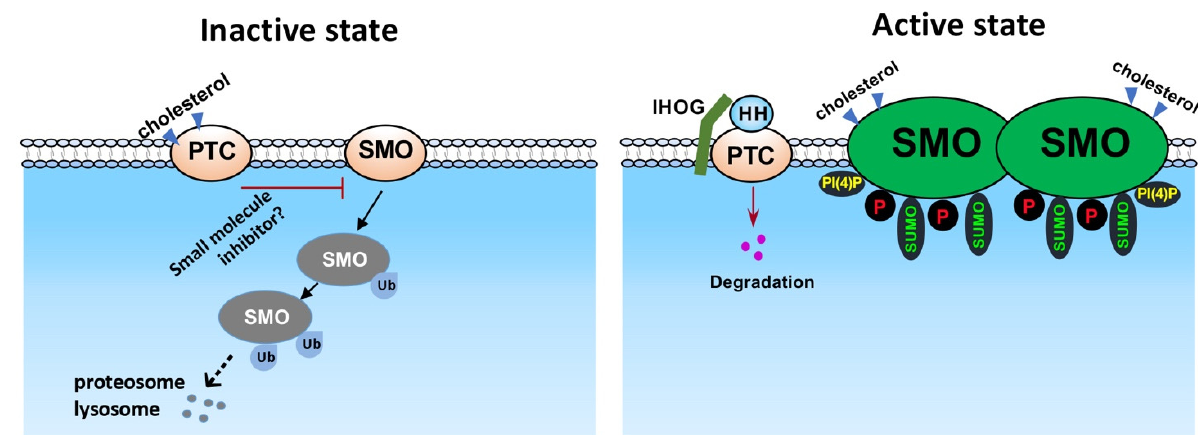
Figure 2. SMO regulation in HH signaling. Shown here is a scheme of SMO regulation through different mechanisms. In the absence of HH, unphosphorylated SMO is ubiquitinated and degraded through proteosomes and lysosomes. In the presence of HH, SMO is phosphorylated by multiple kinases. Lysine residues in the C-tail of SMO are sumoylated to counteract ubiquitination. Phosphorylation and dimmerization leads to the cell surface accumulation and activation of SMO. Both PI(4)P and chelesterol can activate SMO upon HH stimulation.